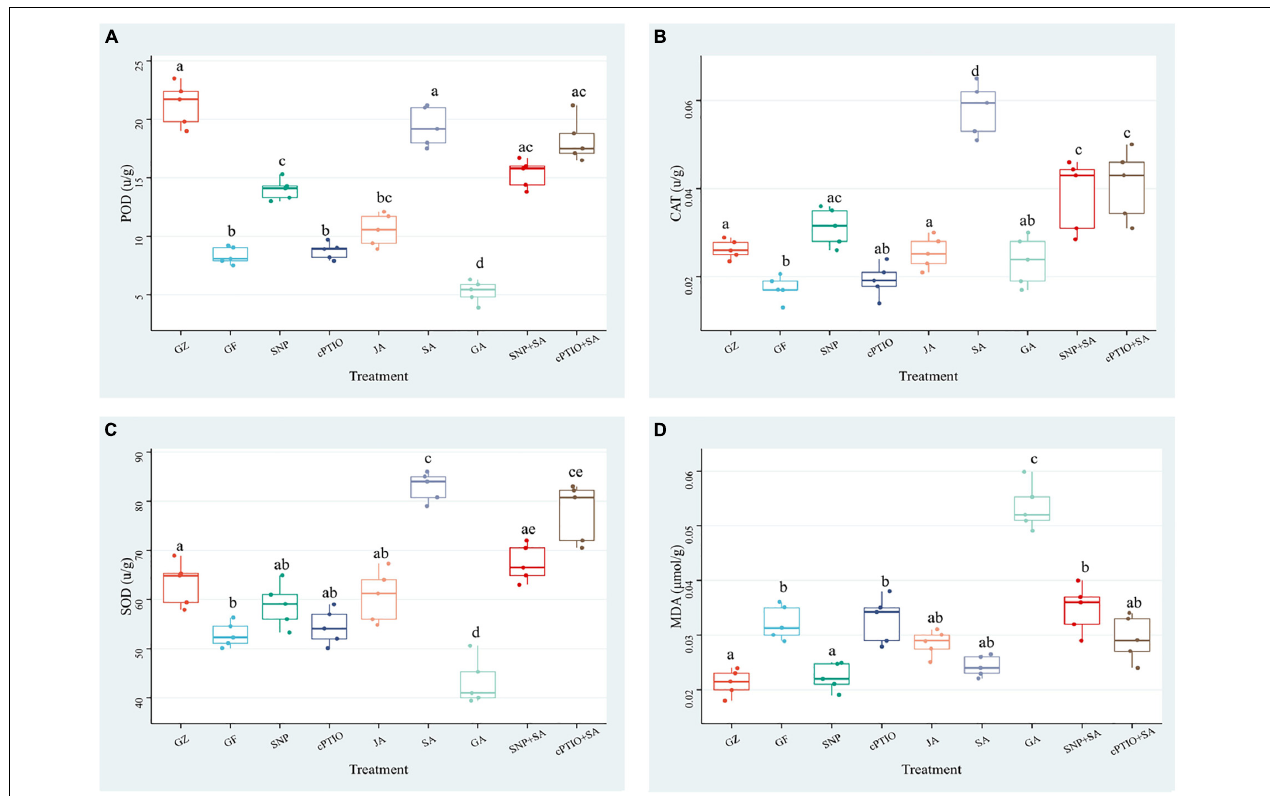
FIGURE 10 | Effect of NO effectors and/or phytohormones on the activities of determination of peroxidase (POD) (A) , catalase (CAT) (B) , superoxide dismutase (SOD) (C) , and the content of malondialdehyde (MDA) (D) in T. hemsleyanum under the photovoltaic condition (GF) and the normal light condition (GZ). Data are means ± SE of the three technical replicates from five seedlings for each treatment. Means that do not share a same letter are significantly different at p ≤ 0.05 level through a Tukey’s